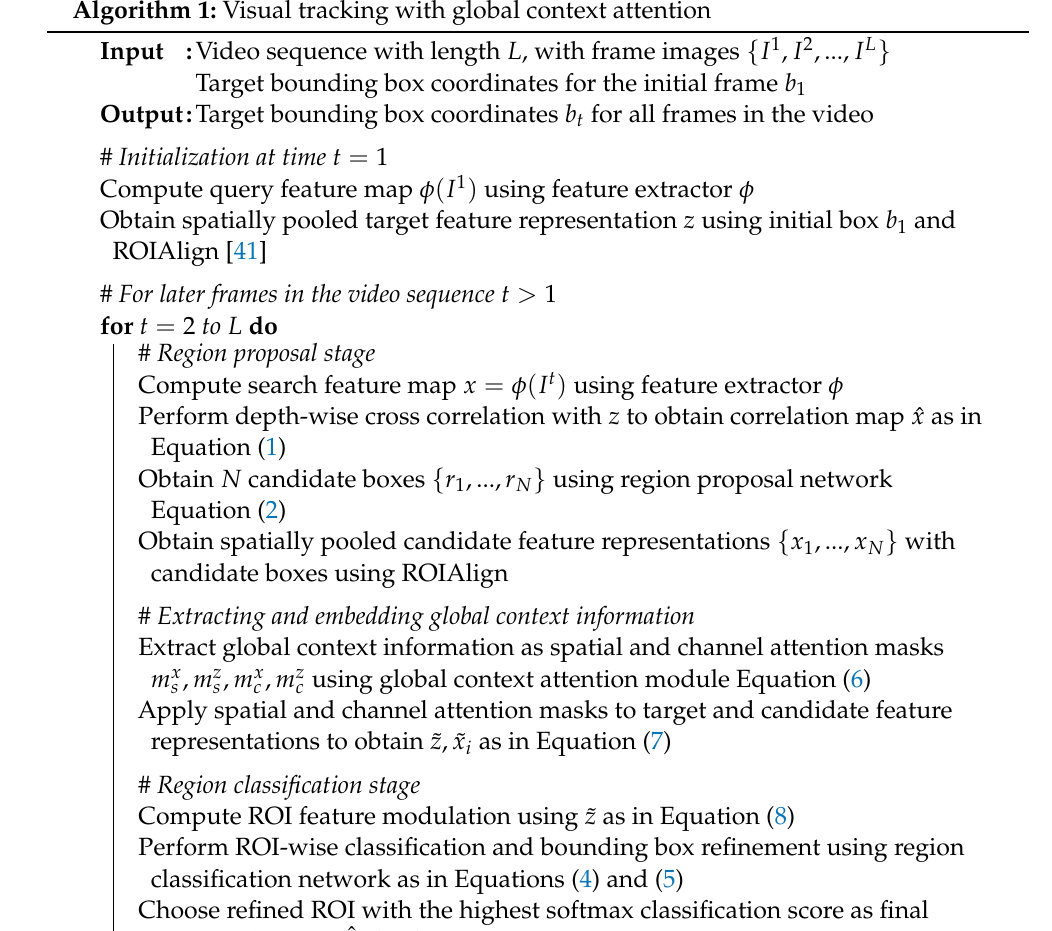
Algorithm 1: Visual tracking with global context